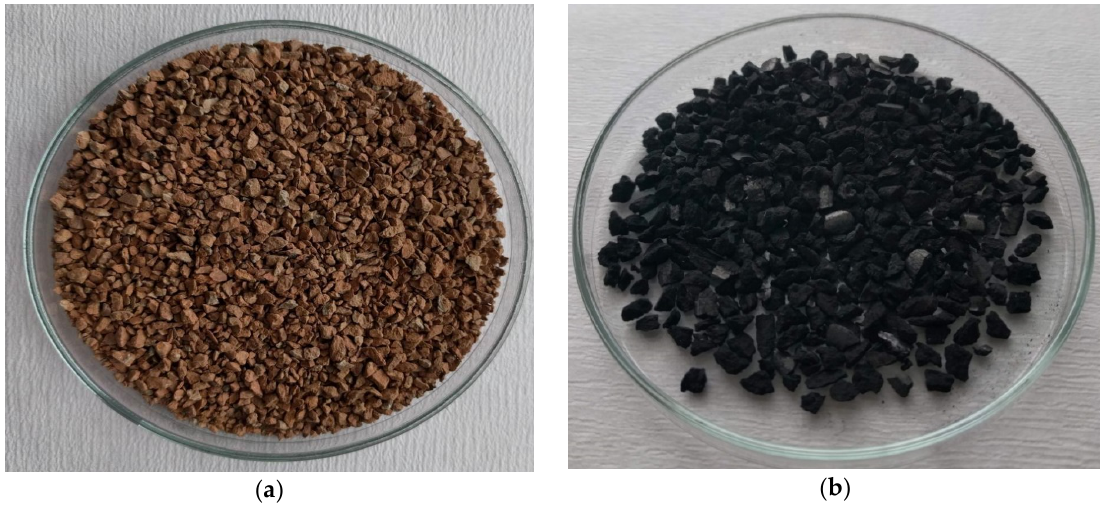
Figure 4. Particulate clay ( a ) and tire pyrolysis char ( b ) used for the catalyst preparation for model tar component decomposition.